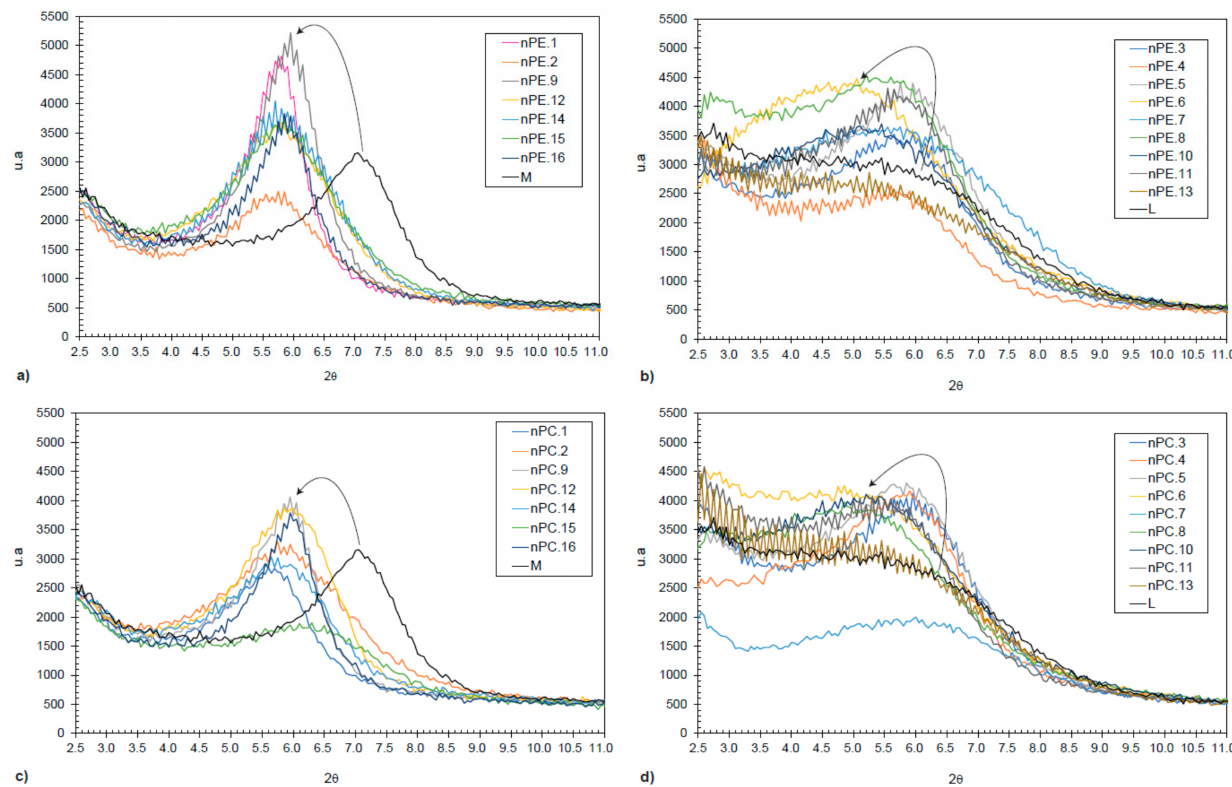
Figure 15. XRD patterns from; PE hybrid pigments with M ( a ), L ( b ) clays, PC hybrid pigments with M ( c ), and L ( d )